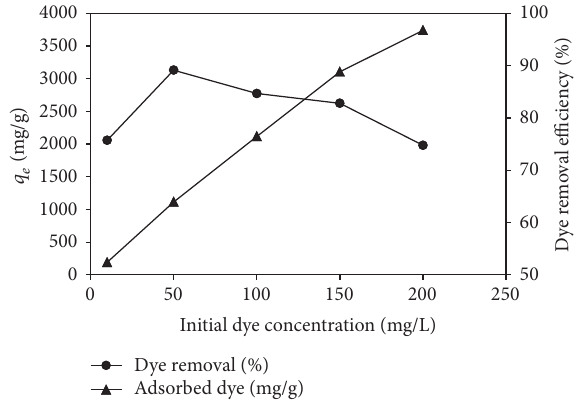
F 6: Effect of initial dye concentrations on RR-120 adsorption onto SWCNTs. (Adsorbent dosage = 0.04g/L, contact time